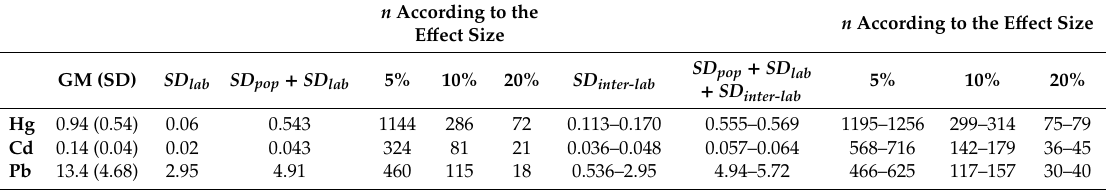
Table 3. The sample size ( n ) required to observe 5, 10, and 20% di ff erences in blood levels of Hg, Cd, and Pb between population groups (e ff ect size). Combined SDs include SD lab , SD inter-lab , and SD pop . Statistical power = 0.90; α = 0.05; one-sided. GM, geometric mean of the study population; SD, standard